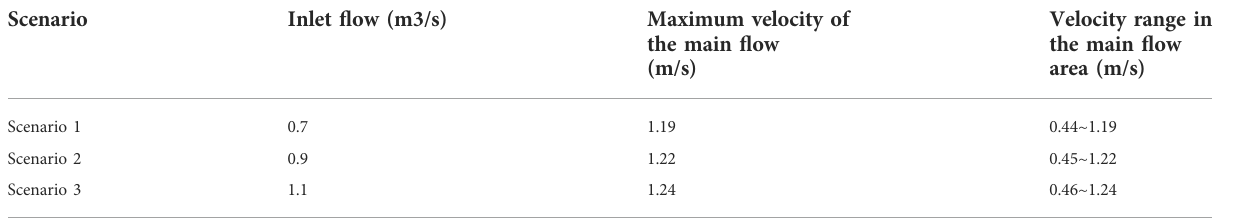
TABLE 5 Calculation results of fl ow rate under different